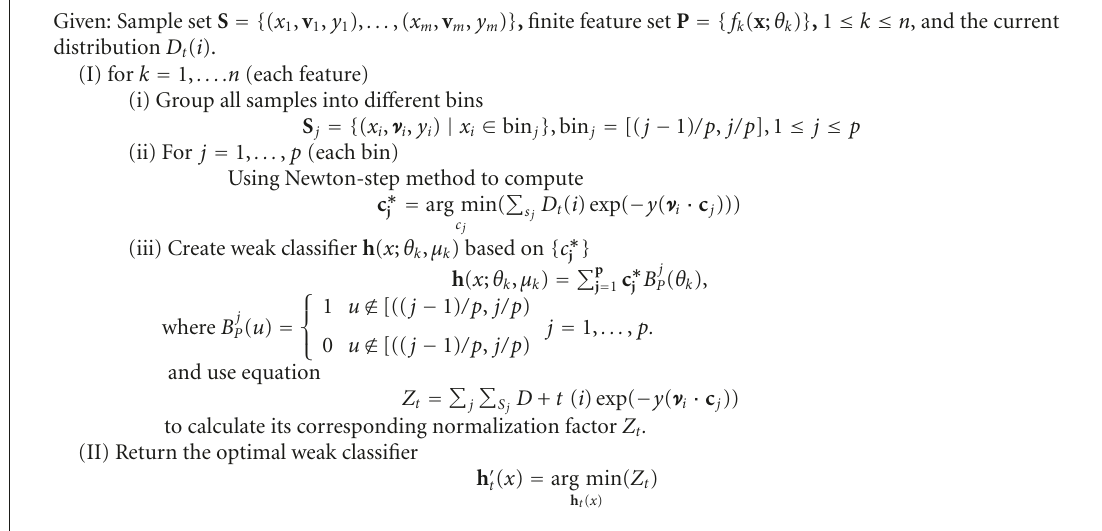
Algorithm 3: Training of the first stage of weak classifier with piece-wise